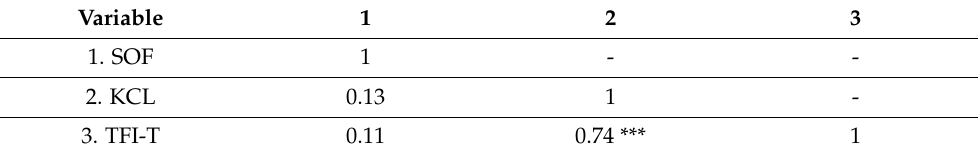
Table 2. Correlation matrix for the TFI-T, SOF and KCL ( N = 210).